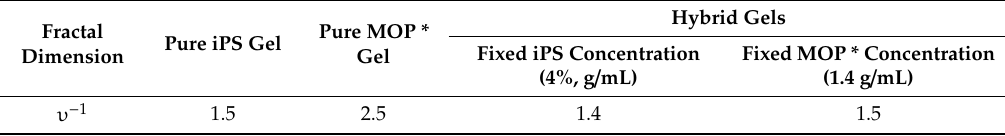
Table 2. Fractal dimension obtained by the correlation G α C (3 υ + 1) / (3 υ − 1) extracted from Figure 6.